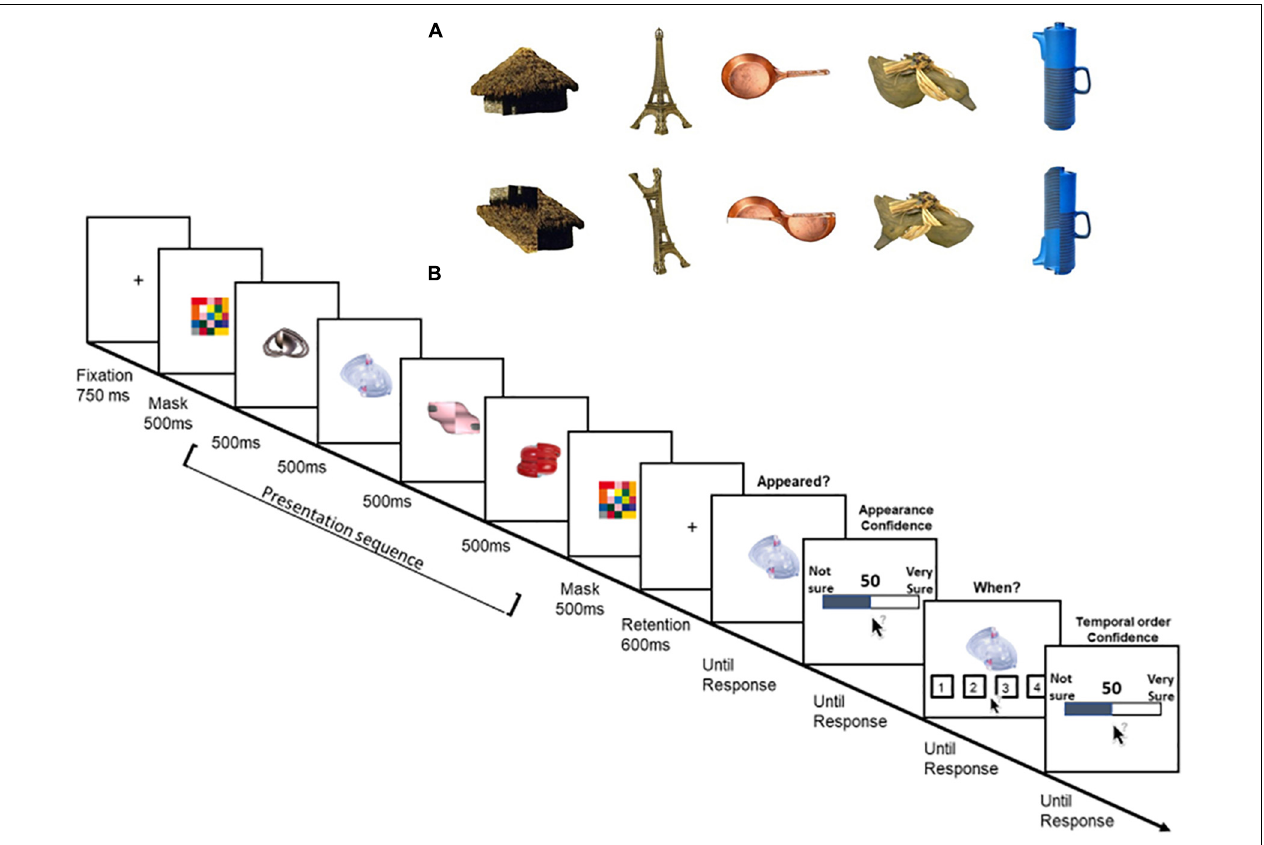
FIGURE 4 | (A) Examples of items used in Experiment 3. Top row: high-semantic, intact items. Bottom row: low-semantic, distorted items. (B) Schematic illustration of a trial’s sequence in the low-semantic condition of Experiment 3.